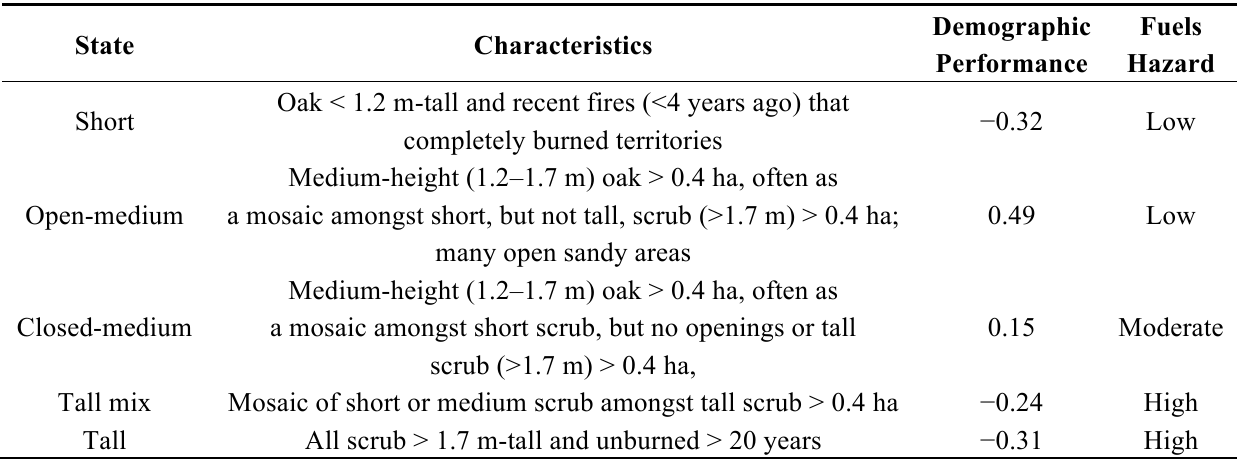
Table 1. Habitat states used to quantify landscape units as potential territories (10 ha) of Florida scrub-jays (FSJs) directly related to long-term demographic performance (yearling production rates; breeder mortality rates) and fire history successional patterns (adapted from [8–10]). Populations are expected to increase in landscapes dominated by source territories (positive demographic performance) or to decrease in landscapes dominated by sink territories (negative demographic performance). We also include predictions about the fuels hazards associated with these